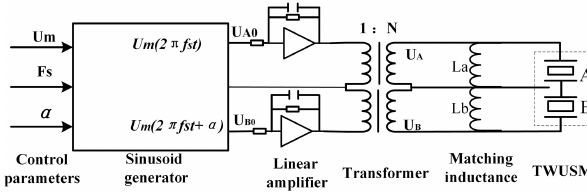
Figure 2. The framework of the driving circuit.